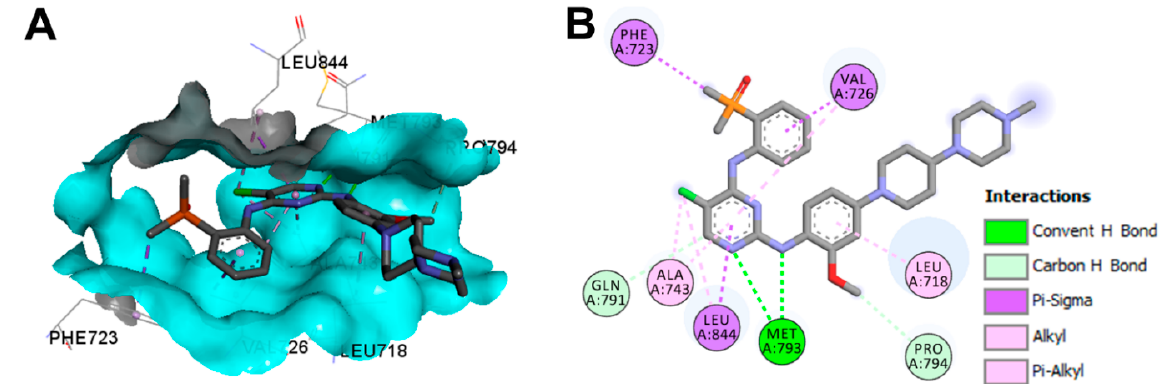
Figure 17. Kinase inhibitory activities of brigatinib.